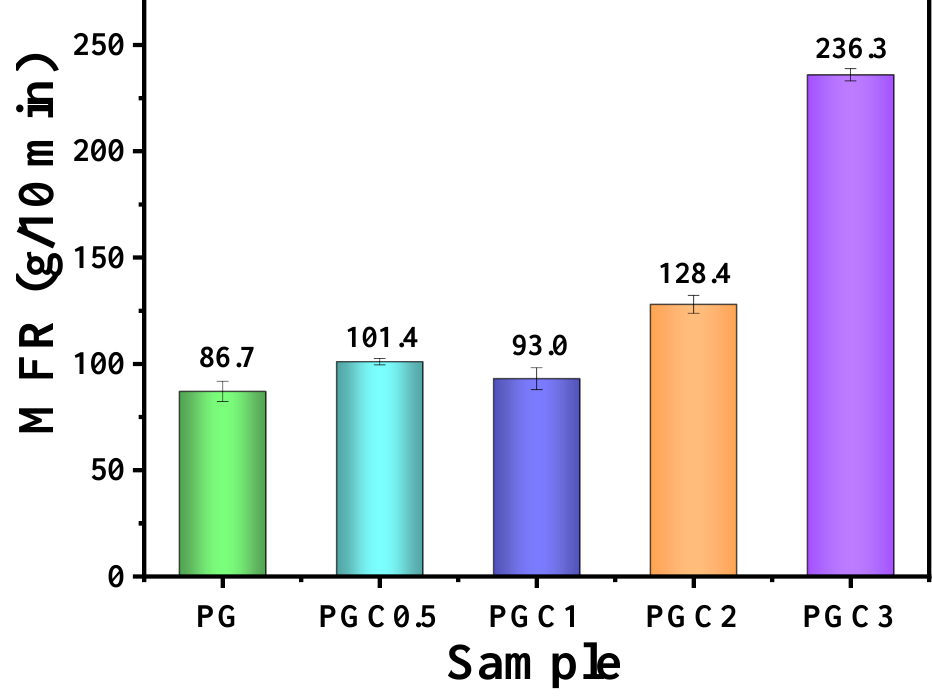
polyphenols (C) destroyed the regularity of the PP molecular chains, which induced the defect in the PP crystals and generated the PP crystals with different perfection. Figure 2. MFR of the PP/DCP/GMA/C blends with different tea polyphenols (C) loading.